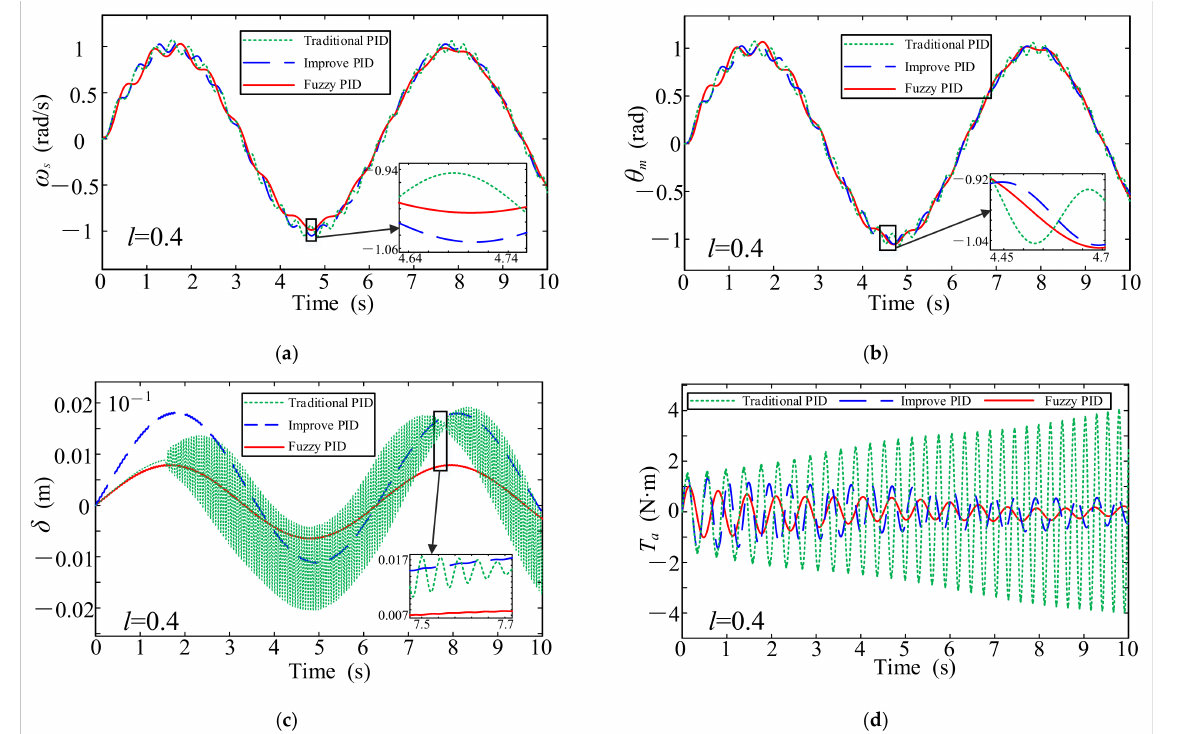
Figure 6. The output curve of the flexible load side in case 1: ( a ) the output speed; ( b ) the output angle; ( c ) output elastic deformation; ( d ) the output torque.